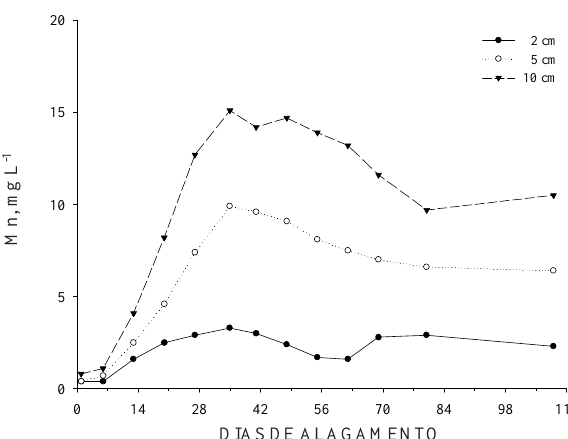
Figura 3. Concentração de manganês na solução do solo em três profundidades de um Planossolo submetido a alagamento.